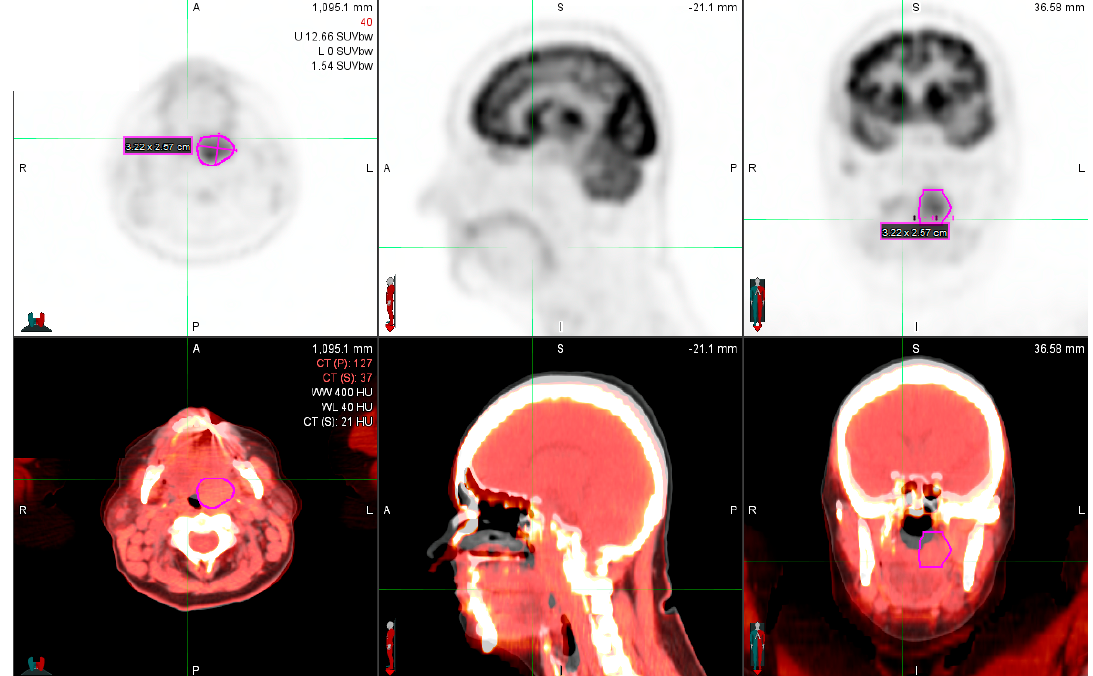
Figure 2. Left palatine tonsil primary tumor (MiM 7.0 fusion) obtained in one patient – initial scanning at 60min.p.i. (upper images: PET, below—PET/CT fusion).